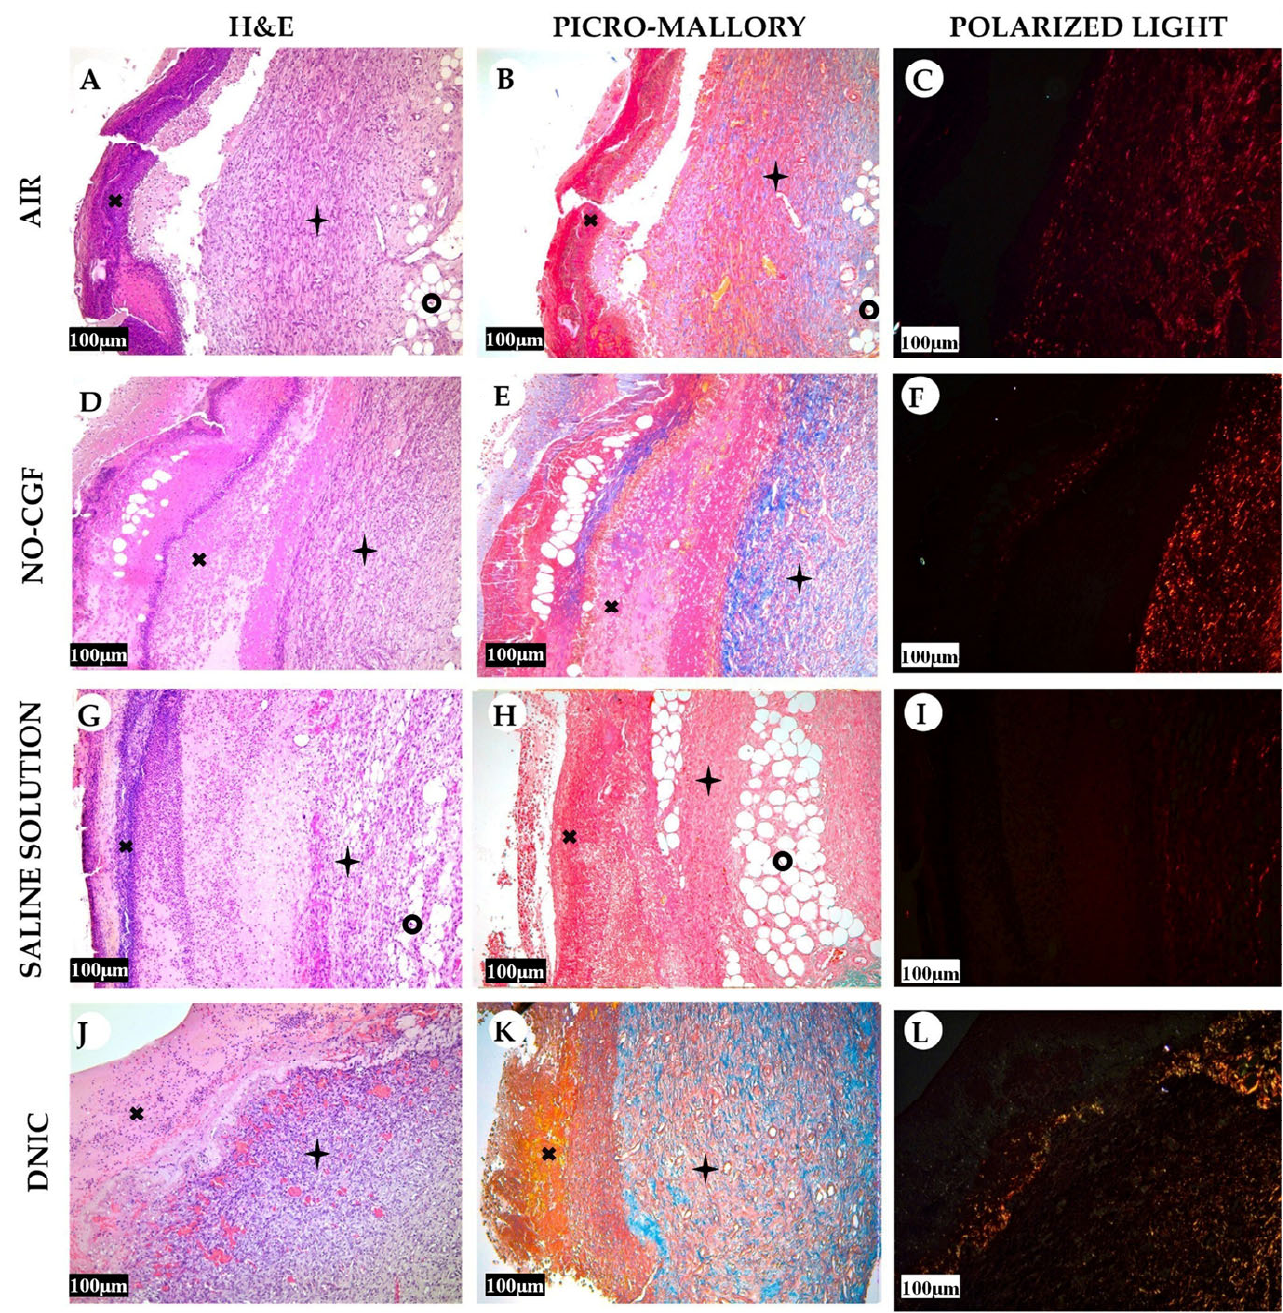
Figure 10. Histology of the wounds at post-operative day 7, hematoxylin and eosin staining ( A , D , G , J ), picro-Mallory staining ( B , E , H , K ) staining and polarized light microscopy ( C , F , I , L ); scale bar—100 µ